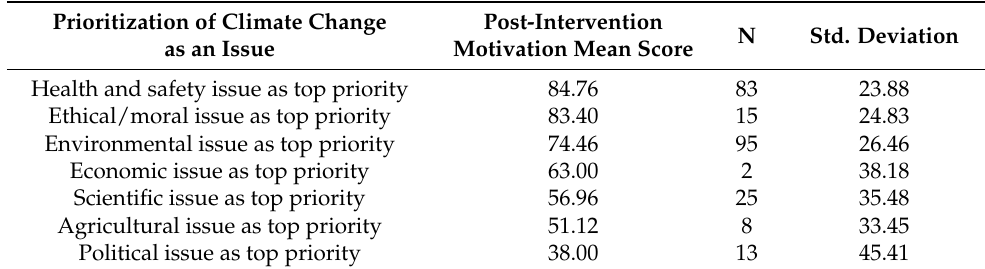
Table 2. Comparison of Post-intervention Motivation Scores with Post-intervention Top Ranking Frameworks for Conceptualizing Climate Change Issue.